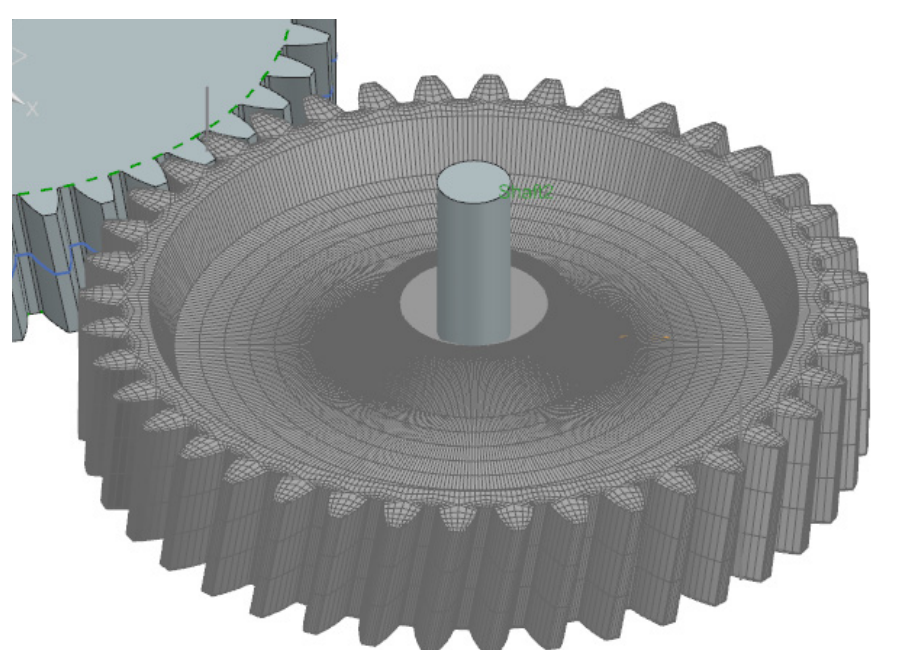
Figure 8. FE model of the lightweight driven gear. Table 2. Design variables ranges.